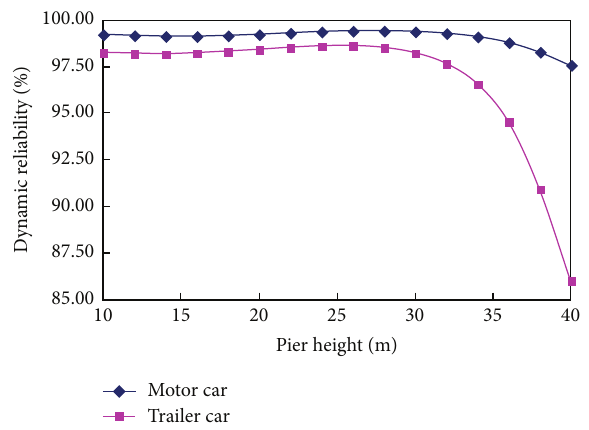
Figure 21: Dynamic reliability for lateral wheelset force with respect to pier height.